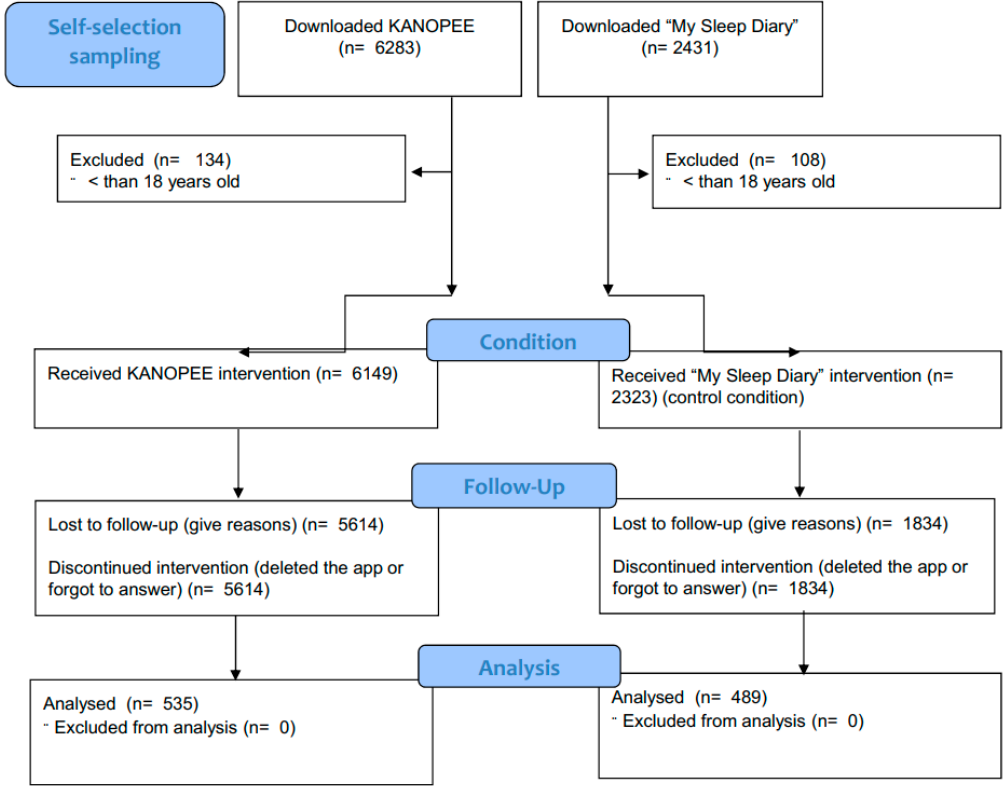
Figure 2. Participant flow.